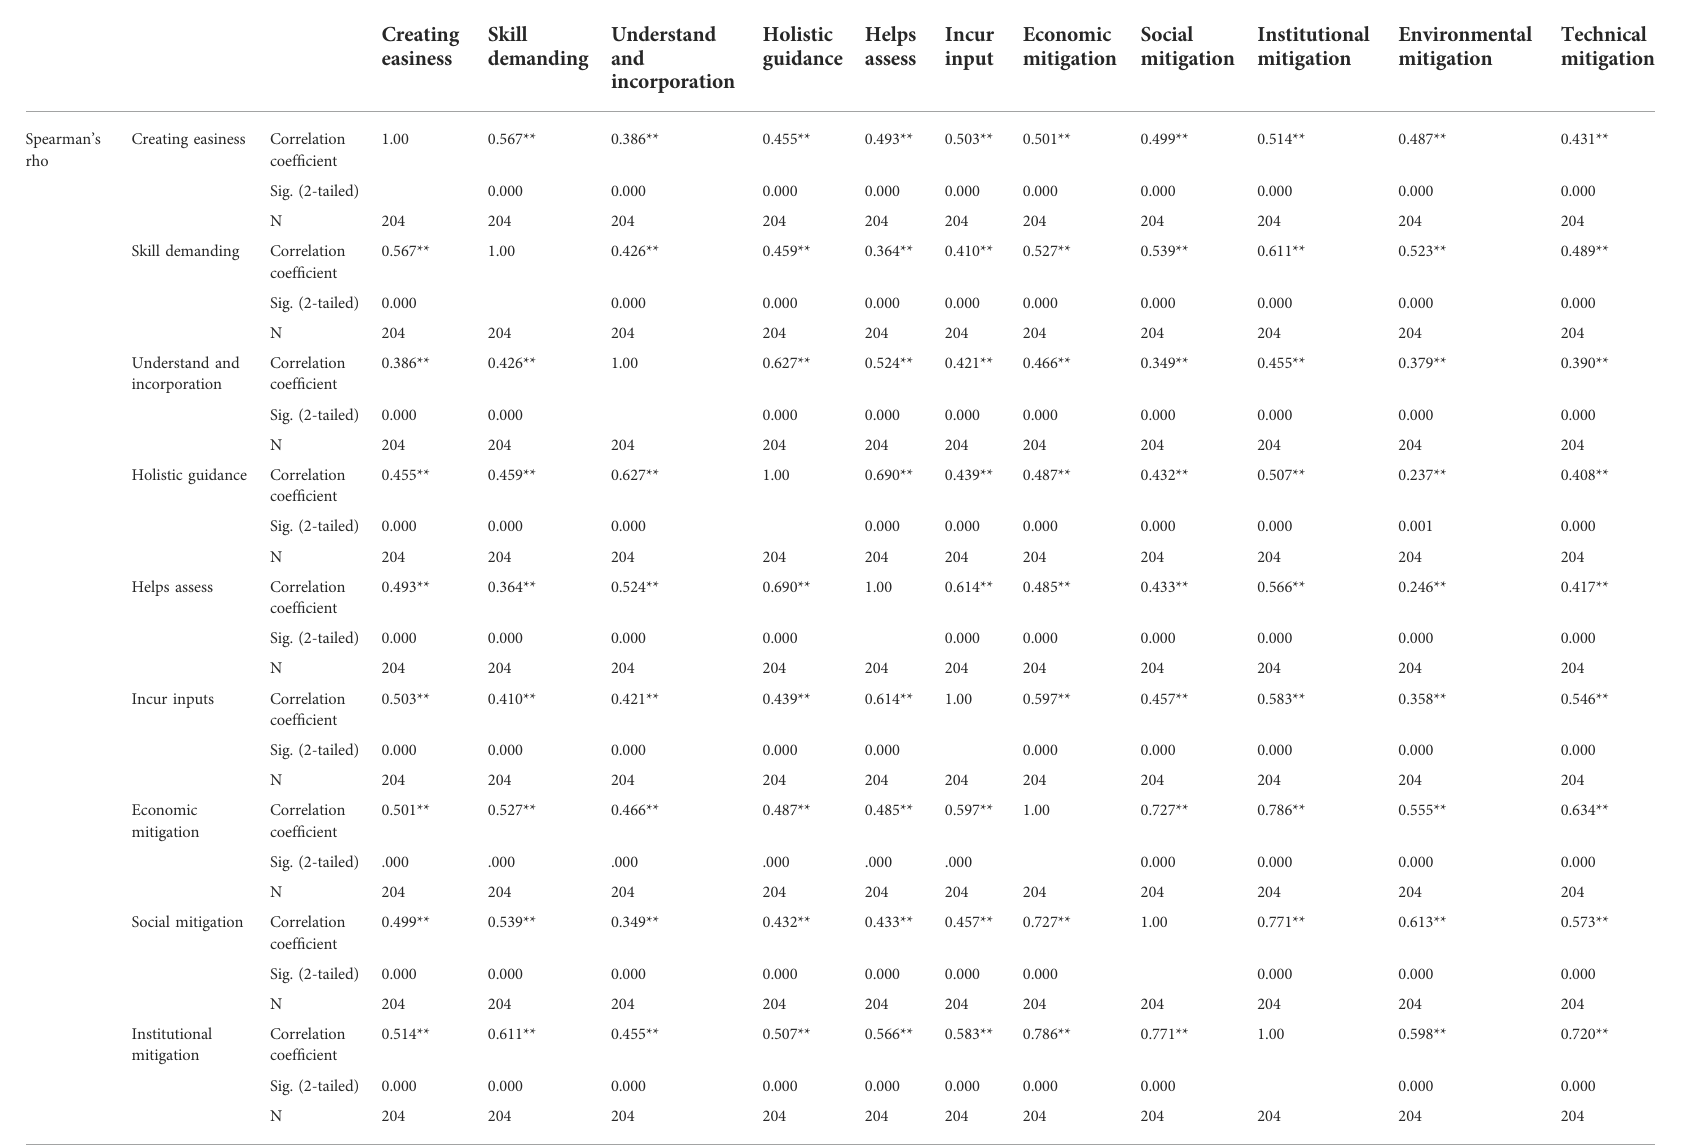
TABLE 3 Spearman ’ s rank-order correlation coef fi cient for the role of the